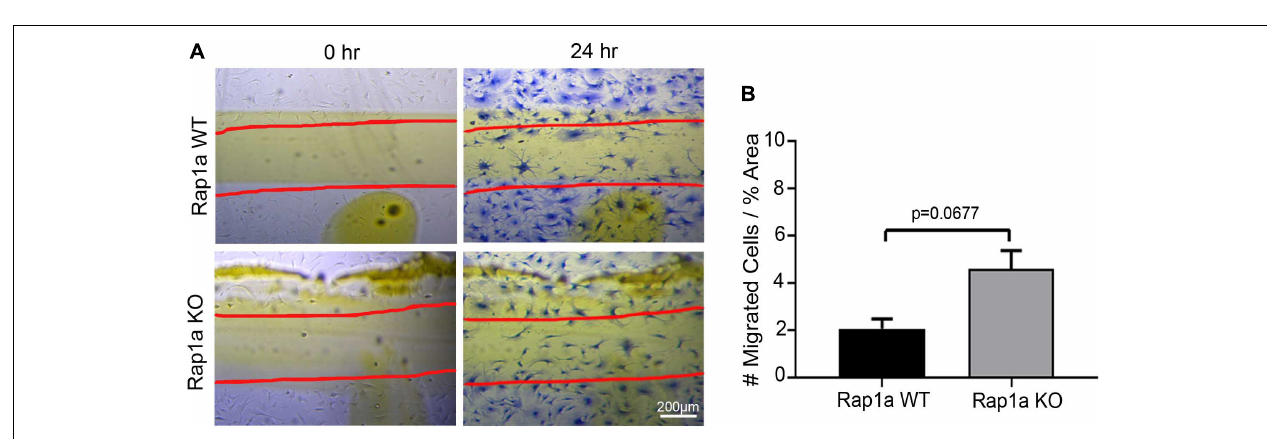
FIGURE 3 | Knockout of Rap1a led to an increase in cardiac fibroblast migraiton. Cardiac fibroblasts were isolated from Rap1a WT and KO hearts, cultured on plastic cell culture dish, scratched (0 h) and assessed for migration after 24 h (A) . Scratched lines were depicted with red lines and cells were stained with Coomassie blue for visualization (40 × and scale bar = 200 µ m). Number of migrated cells were normalized to percent scratched area and graphed as mean ± SEM ( B ; n = 6–10). Statistical anayslsis consisted of Student’s t -test.